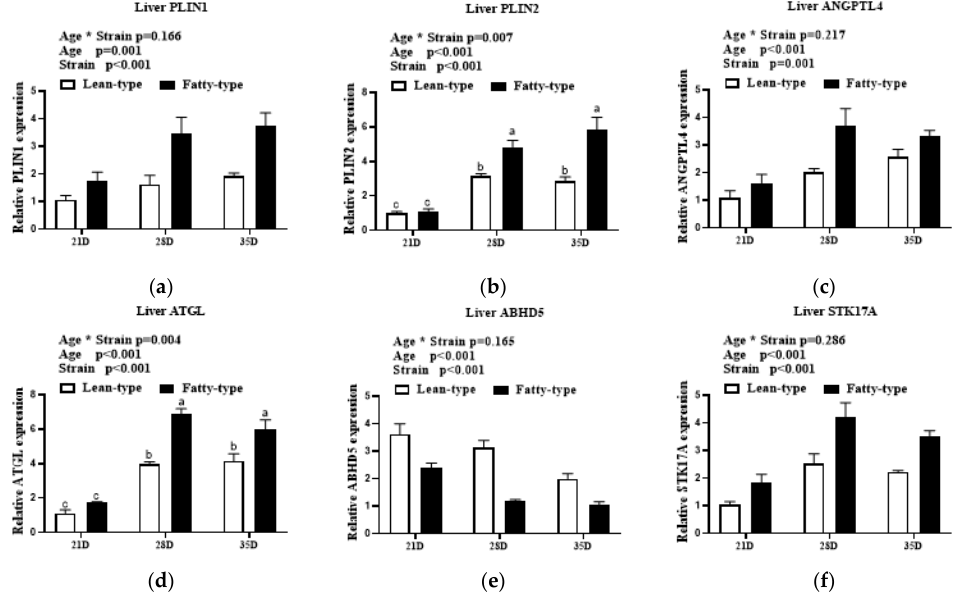
Figure 5. Comparison of expression levels of lipid droplet anabolism genes in liver ( a – f ) at 21 D, 28 D, and 35 D between two strains of meat ducks. Data are given as means and standard error of the mean ( n = 6). Bars with different letters are significantly different ( p < 0.05). * In the figure represents the interaction between the two factors. Abbreviations: PLIN1 , perilipin 1; PLIN2 , perilipin 2; ANGPTL4 , angiopoietin-like protein 4; ATGL , adipose triglyceride lipase; ABHD5 , abhydrolase domain containing 5; STK17A ; serine/threonine kinase 17a.